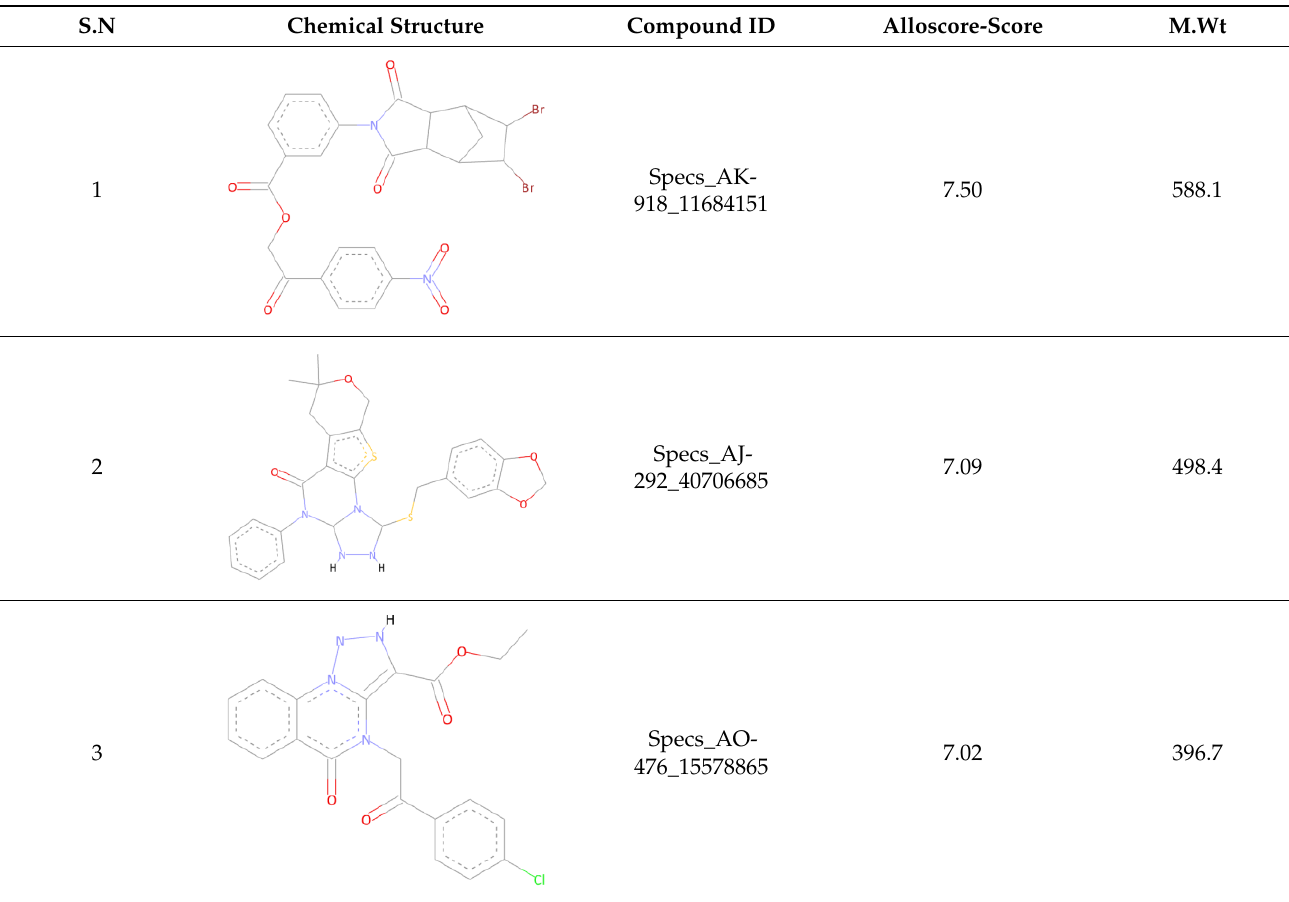
Table 4. Chemical structures, compound IDs, molecular weights, and alloscore-score rankings from the SPECS diversity library.